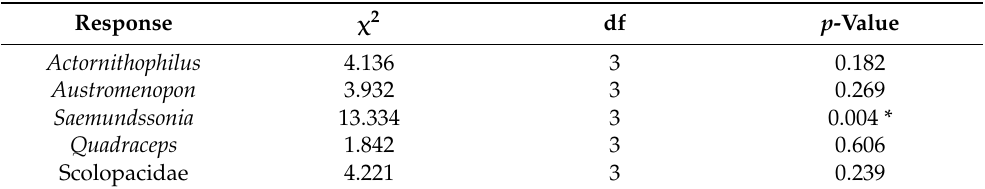
Table 9. Likelihood ratio test results for fitted model with migration length and host length compared to null model (containing only the random effect). An asterisk (*) designates the only statistically significant value.